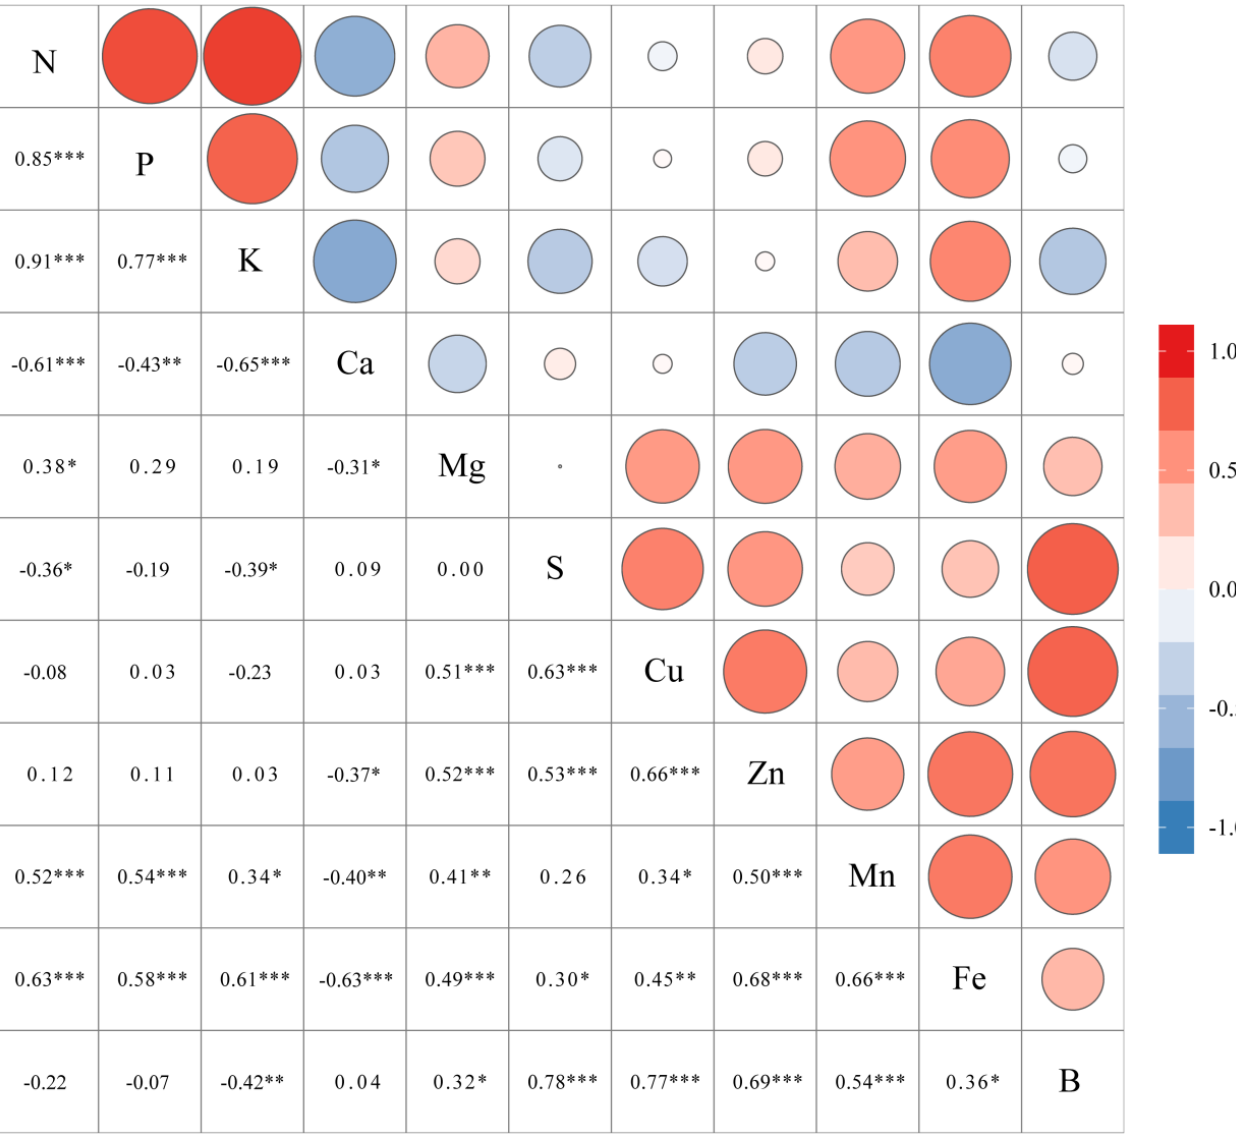
Figure 11. Correlation analysis of absorption of different elements. Note: * Statistical significance, i.e., p < 0.05; ** Statistical significance, i.e., p < 0.01; *** Statistical significance, i.e., p < 0.001. Further path analysis shows (Figure 12) that Fe and Mn had direct effects on the absorption of N, P and K. Direct path coefficients were 0.591, 0.609, 0.732 and 0.783, 0.490 and 0.267 for Fe, Mn, N, P and K, respectively. B induced impacts on K absorption with the direct path coefficient of − 0.660. A correlation among Mg and Zn and Fe absorption with path coefficients of 0.662 and 0.681. The correlation between S and Cu absorption and B absorption was noticed with path coefficients of 0.783 and